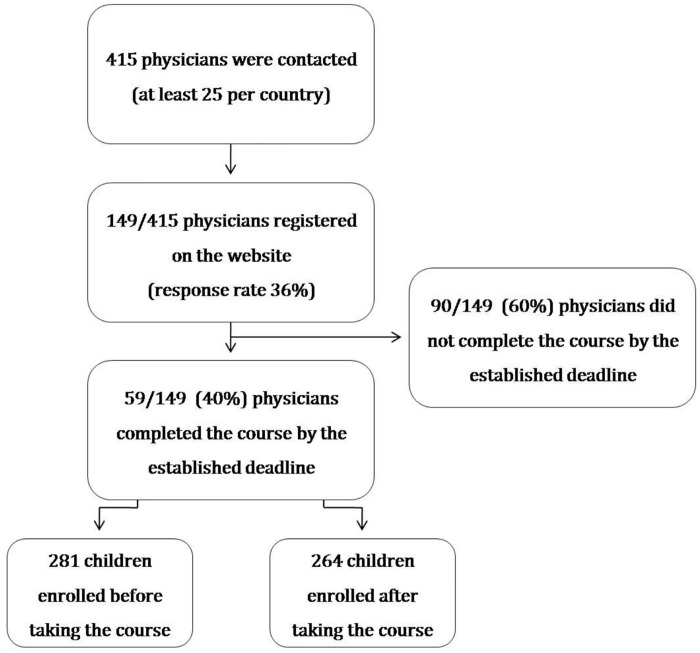
Study design: flowchart of the participants.